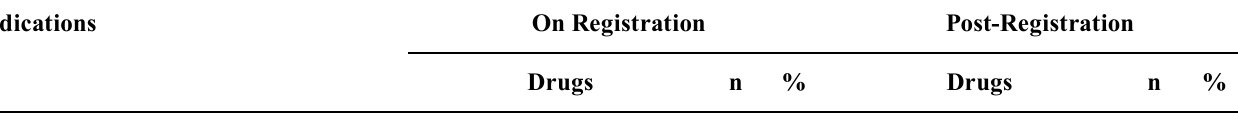
TABLE II – Indication of the 46 medicines with pediatric indication identified in the cohort of new drugs registered from 2003 to 2013